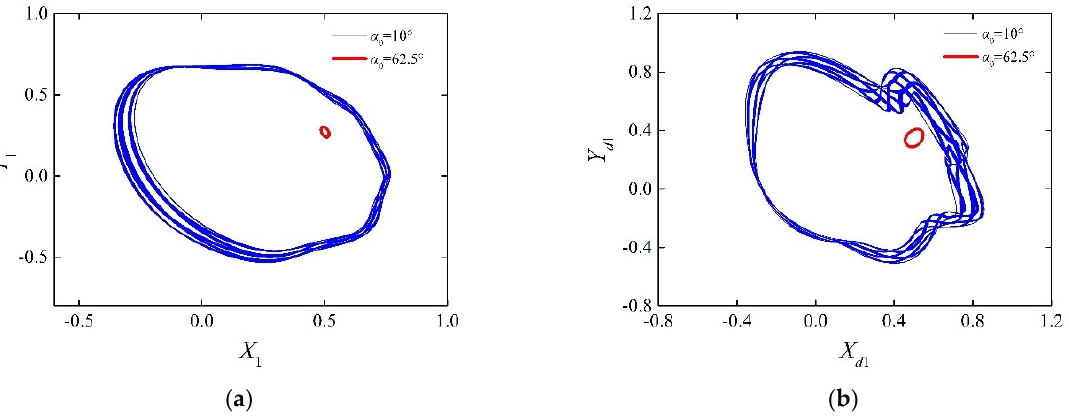
Figure 10. When ω = 1500 rad/s, comparison of the rod–fastened rotor at α 0 = 10° and 62.5°: ( a ) comparison of the orbits at the left bearing station; ( b ) comparison of the orbits at the left disk station.